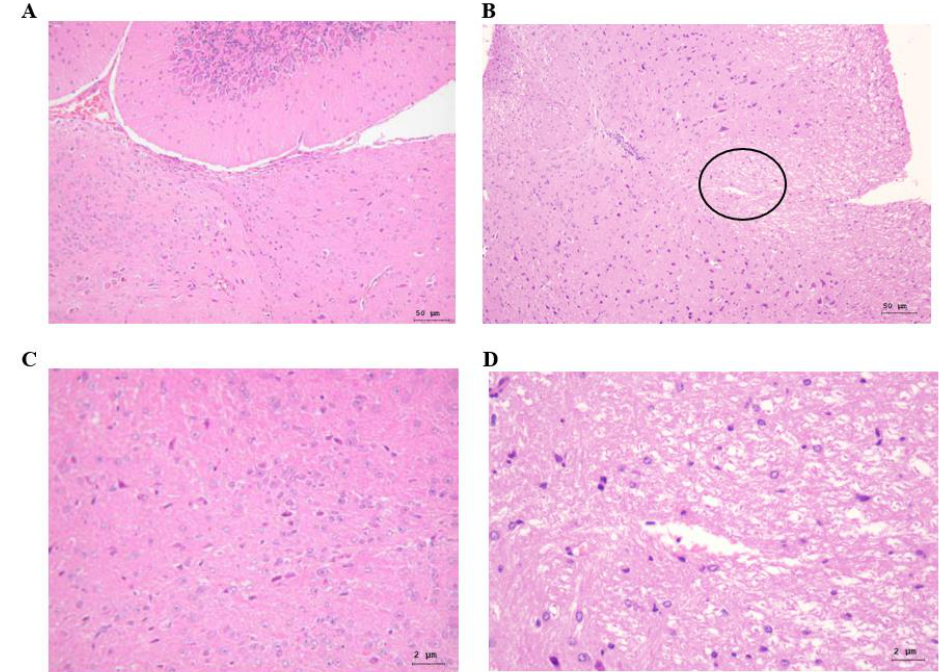
Figure 4. Histopathological changes in the brain tissue of PRV-infected mice. Histopathological findings in the brain of MOCK ( A , C ), uninfected and PRV-infected mice ( B , D ) at 2 dpi. No significant lesions were found in the brain and stem ( A , C ). In the brain stem of PRV-infected mice ( B , D ), necrosis (circle) was found. A, B. 20×, C, D. 400×, H/E stain.